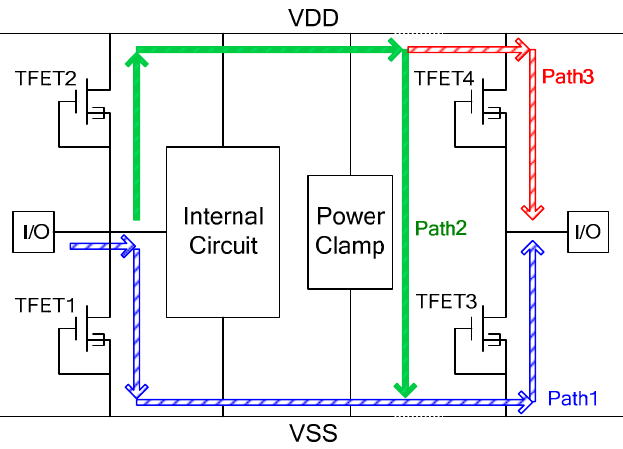
Figure 2. Schematic of the ESD protection network with TFETs.